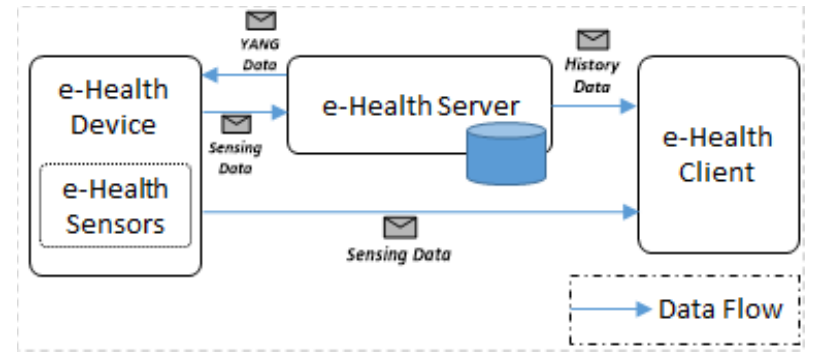
Figure 4. Interaction of components in the e-Health system.